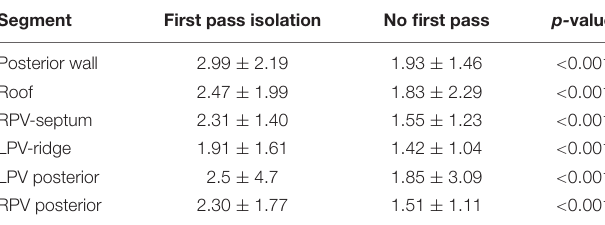
TABLE 1 | Patients’ baseline characteristics at the time of ablation.